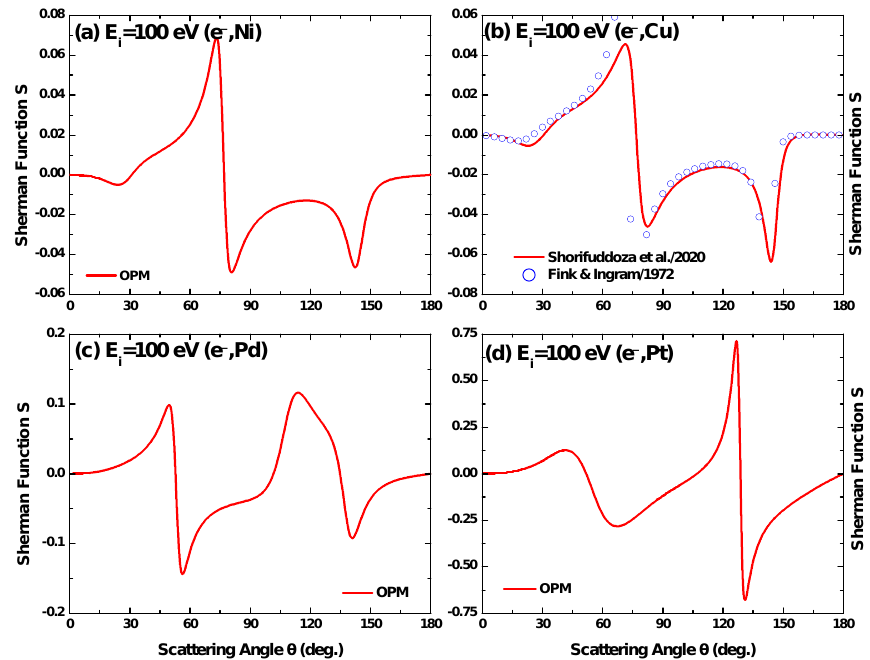
Figure 11. Angular variation of the Sherman function for electron scattering from ( a ) Ni 58 , ( b ) Cu 63 , ( c ) Pd 108 , and ( d ) Pt 196 at impact energy E i = 100 eV as computed by the present OPM (——) and by Fink and Ingram ( ◦ ◦ ◦ )